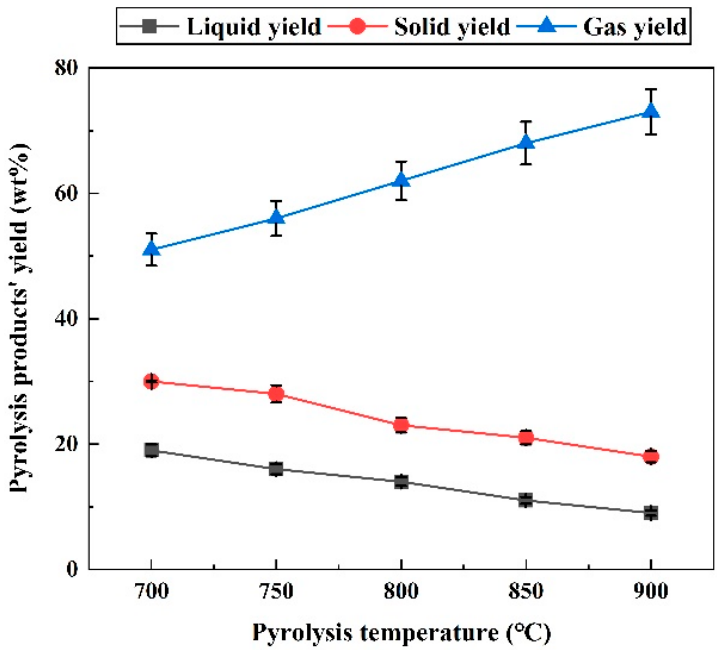
Figure 1. Effect of temperature on the distribution of pyrolysis products of pine sawdust.